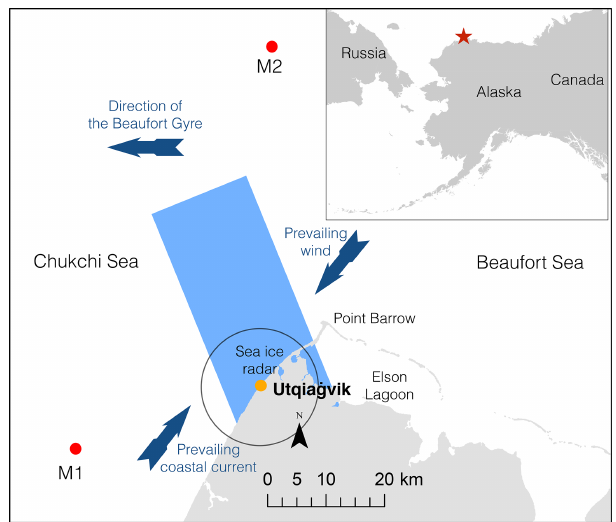
Figure 1. Overview of study region near Utqia˙gvik, Alaska. The blue rectangle signifies the footprint of the SAR acquisitions, and the circle marks the range of the ground-based radar (roughly 11km). Red dots signify location of deployed moorings for assess- ing ocean surface